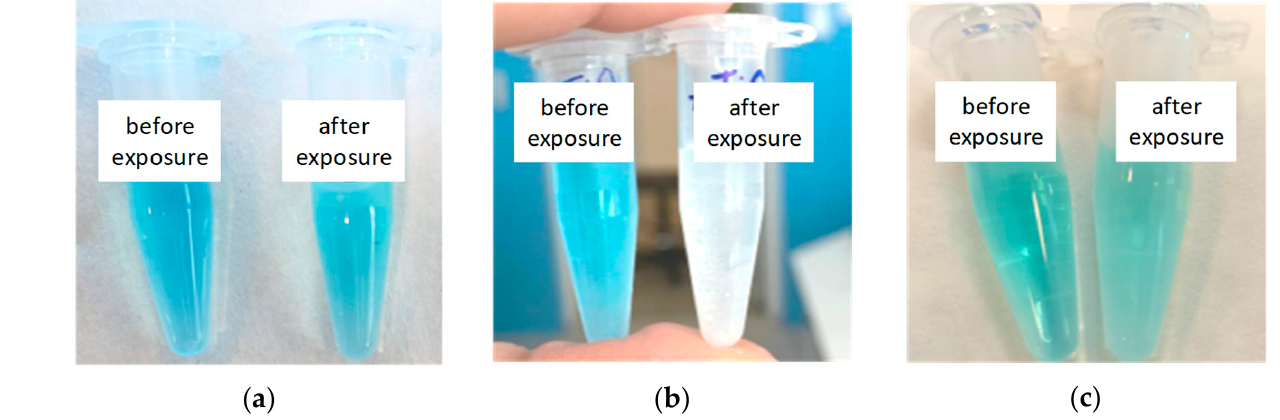
Figure 6. The Eppendorf tubes filled with the 10 − 5 M MB solutions ( a ) free of the TiO 2 and Ag nanoparticles and containing ( b ) TiO 2 or ( c ) Ag nanoparticles before and after UV or LED exposure.